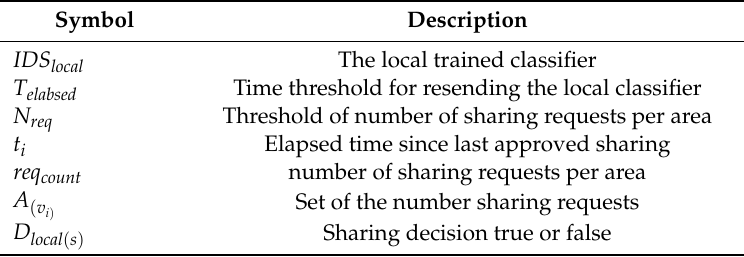
Table 1. Symbols